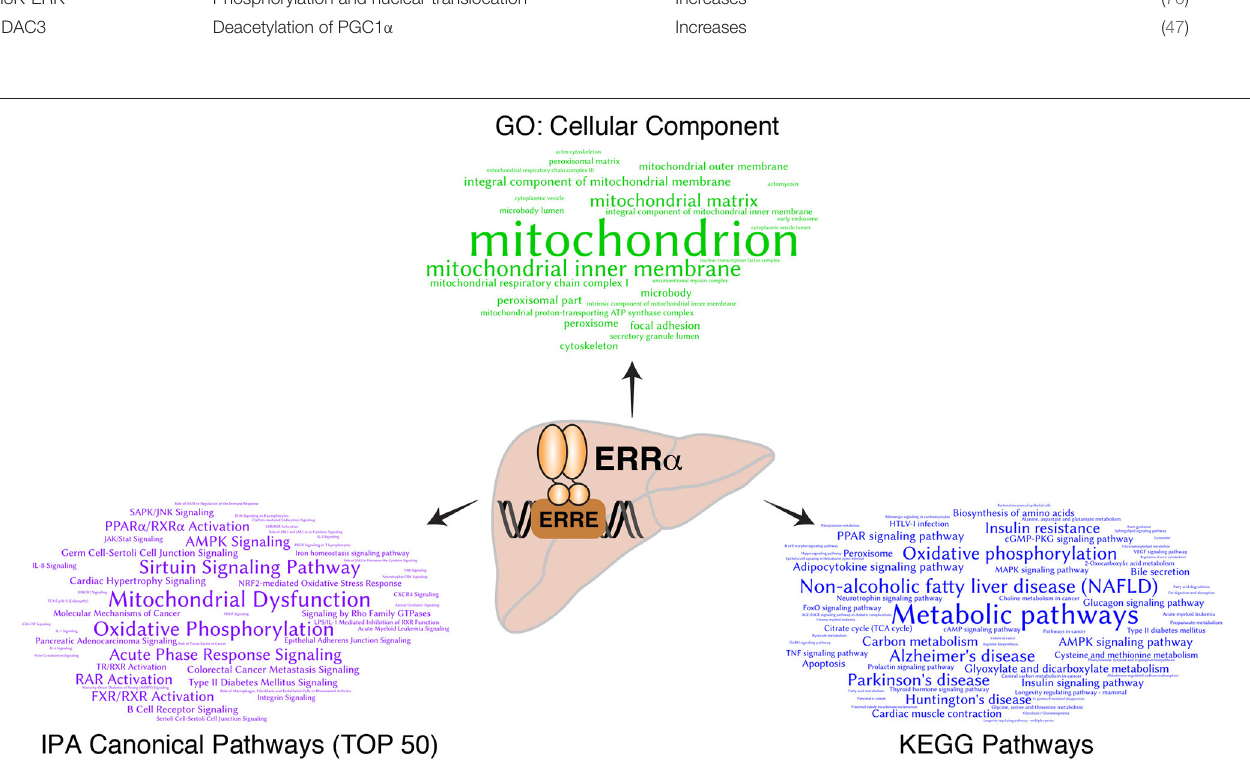
FIGURE 1 | Bioinformatics analysis of direct ERR α target genes in mouse liver. Word clouds representing significantly overrepresented GO cellular component terms (top, green), KEGG pathways (right, blue) and the top 50 canonical pathways from Ingenuity Pathway Analysis (IPA) (left, purple) from the list of ERR α target genes with DNA binding events observed within ± 10kb of their transcription start sites as identified by ChIP-seq analysis (23). The size of the significant terms is reflective of their associated p -values whereby the most significant terms having lower p -values are displayed in larger font size.